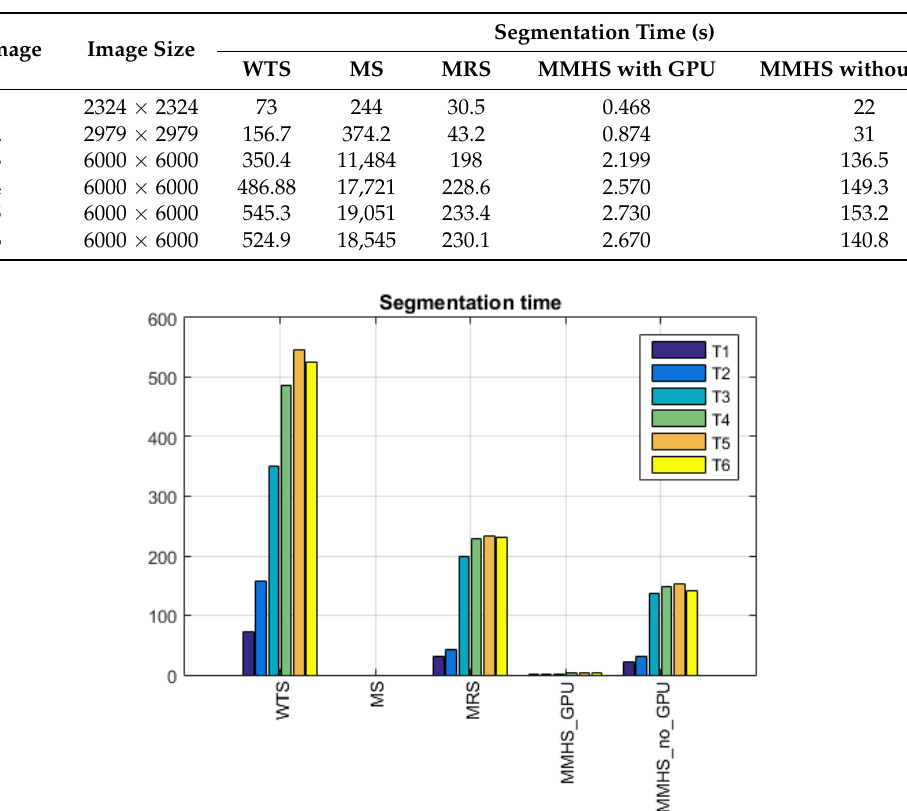
Table 11. The segmentation time of different methods.